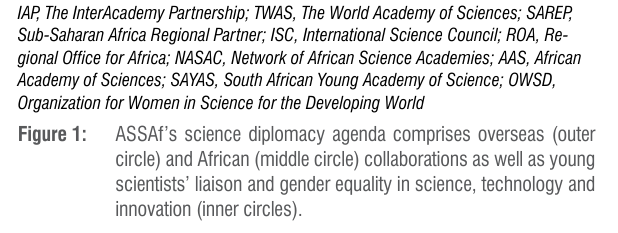
Figure 1: ASSAf’s science diplomacy agenda comprises overseas (outer circle) and African (middle circle) collaborations as well as young scientists’ liaison and gender equality in science, technology and innovation (inner